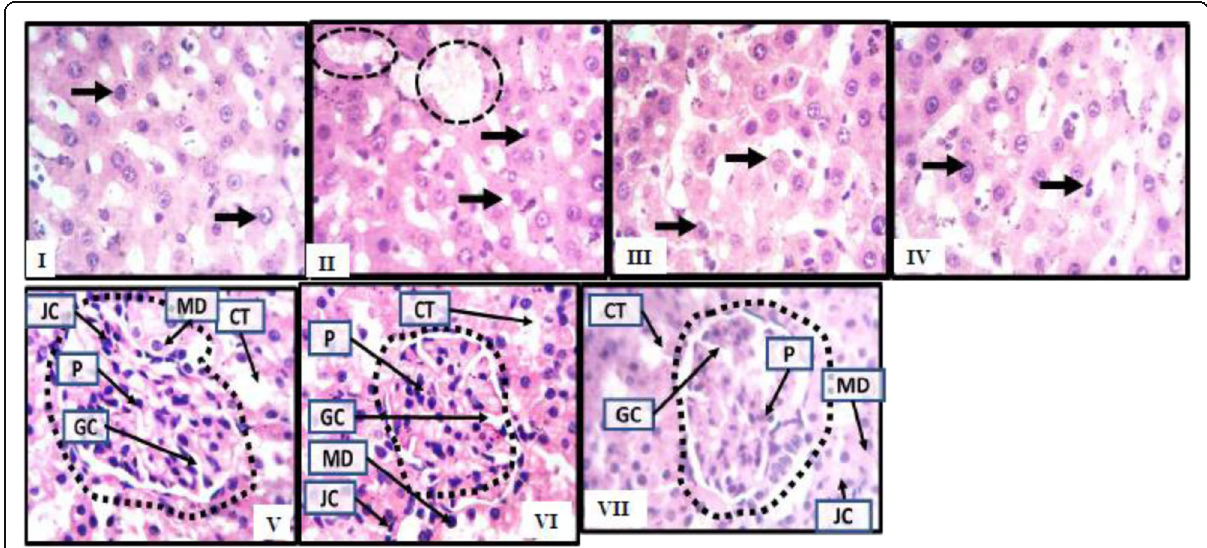
Fig. 1 Photomicrograph of the liver Fig. (I-IV) and kidney Fig. (V-VII) of wistar albino rat under various experimental treatments. I- liver photomicrograph of rats fed with normal feed and distilled water only: Normal histomorphology of the hepatic tissue, distinct hepatocyte nuclei correctly located in the cytosol (black arrows). No noticeable histopathological distortion in the liver tissues. II- liver photomicrograph of rats administered with 3 ml/kg bw CCl 4 only : Distorted liver histoarchitecture (black arrows) with noticeable fatty liver (broken circles). III- liver photomicrograph of rats exposed to 3 ml/kg bw CCl 4 and treated with 100 mg/kg S. acuta: Liver histoarchitecture was normal. No noticeable histopathological distortion was found in the hepatic tissues. IV - liver photomicrograph of rats exposed to 3 ml/kg bw CCl 4 and treated with 100 mg/kg bw Silymarin: Distinctly stained and well positioned hepatocytic nuclei was observed. No histopathological distortion of the liver histoarchitecture . V - kidney photomicrograph of rats administered with distilled water only: Cellular delineation, distribution density and staining were appropriate. No apparent histopathological distortion was observed. VI - kidney photomicrograph of rats administered with 250 mg/kg bw rifampicin only: Marked distortion in renal histoarchitecture coupled with glomerular atrophy. Tubular degeneration, formation of pathological cast, intraluminal exfoliation and observable pyknosis of the nuclei were noticeable. VII- kidney photomicrograph of rats administered with 250 mg/ kg bw rifampicin and treated with 100 mg/kg bw of S. acuta: Normal renal corpuscle with typical cellular delineation, distribution, density and staining intensity. No apparent histopathological alteration. CT - Convoluted tubule, GC- glomerular capillaries, P- podocytes, JC- juxtaglomerular cells MD- macula densa